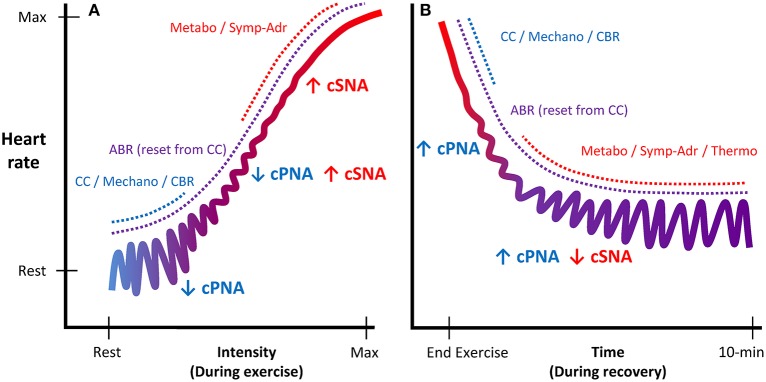
Schematic illustration of autonomic regulation of HR during exercise and recovery. Panel (A) displays HR regulation during exercise as a function of intensity. Panel (B) displays HR regulation during recovery as a function of time. As exercise intensity increases, cardiac control shifts from predominantly parasympathetic control (blue, acting as a “rapid modulator”) to predominantly sympathetic control (red, acting as a “tone-setter”). During recovery, the mechanisms eliciting cardio-acceleration during exercise are reversed, as HR regulation is gradually shifted back to predominantly parasympathetic control. cPNA, cardiac parasympathetic neural activity; cSNA, cardiac sympathetic neural activity; CC, central command; Mechano, mechanoreflex; CBR, central baroreflexes; ABR, arterial baroreflex; Metabo, metaboreflex; Symp-Adr, sympatho-adrenal; Thermo, thermoregulatory influences.